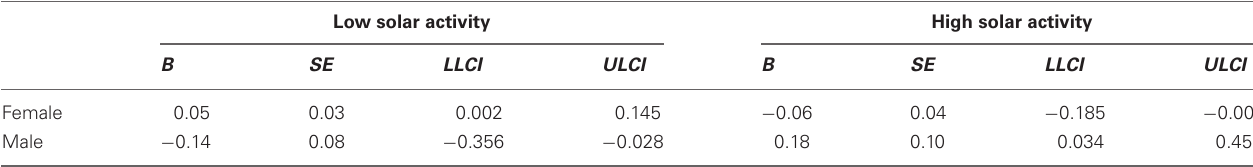
Coding gene variant: G − = 0, G + = 1. Solar activity measured for the 1st trimester of gestation. Bootstrap samples = 1000. Level of confidence (bias corrected) =